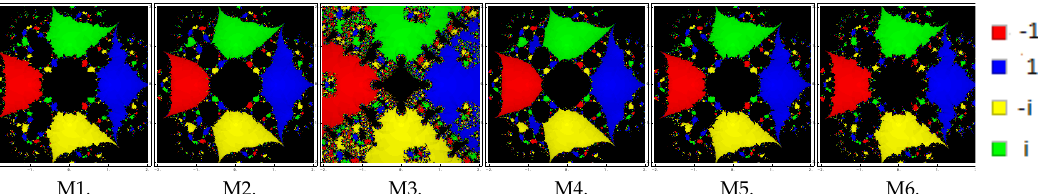
Figure 7. Basins of attraction for polynomial P 3 ( z ) for β = 10 − 2 .